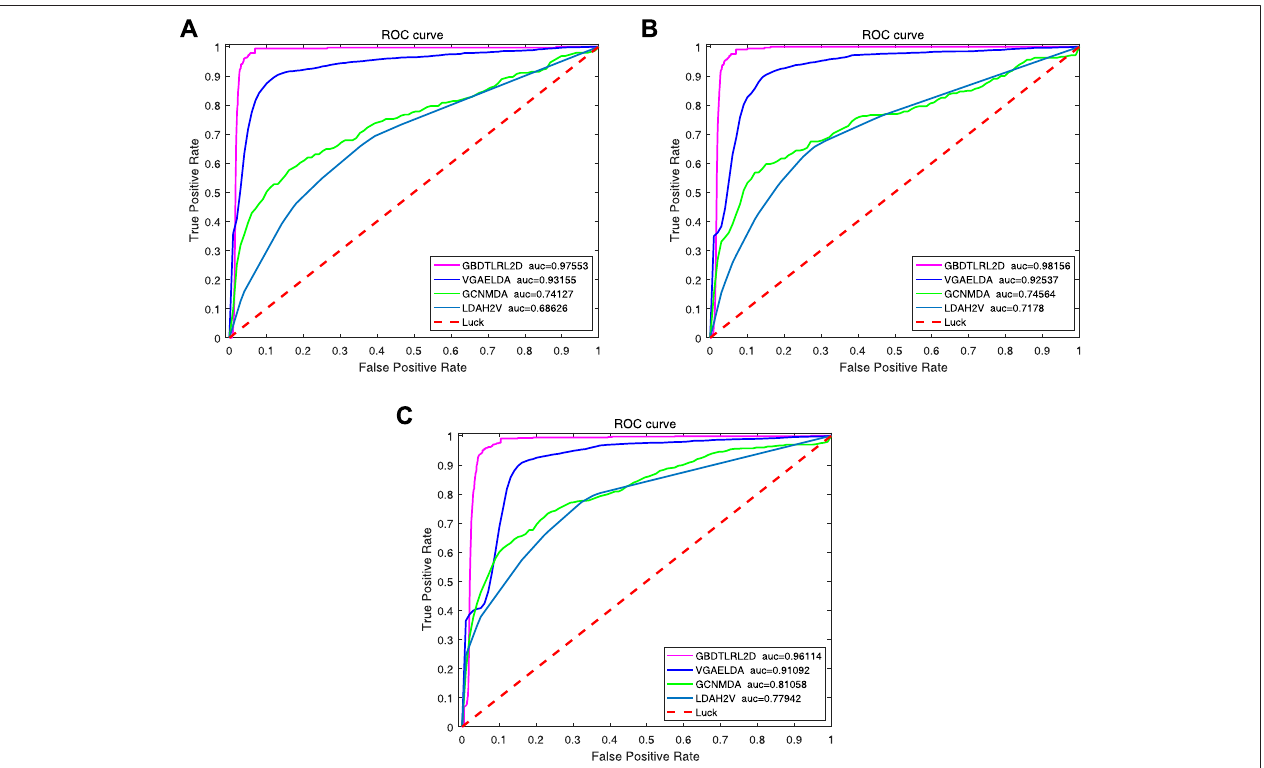
FIGURE 10 | ROC curve comparison with existing methods. ROC, receiver operating characteristic.